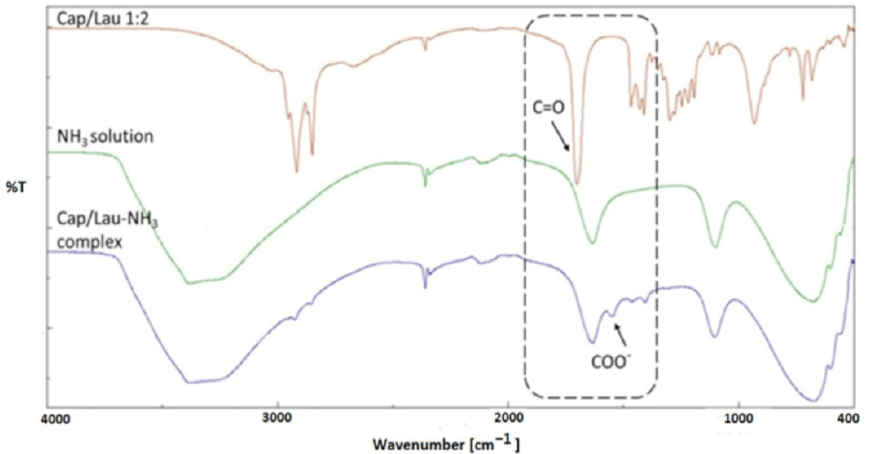
Figure 3. FT-IR spectra of the pure Cap/Lau 1:2 eutectic mixture, ammonia solution as well as Cap/Lau-NH 3 complex.